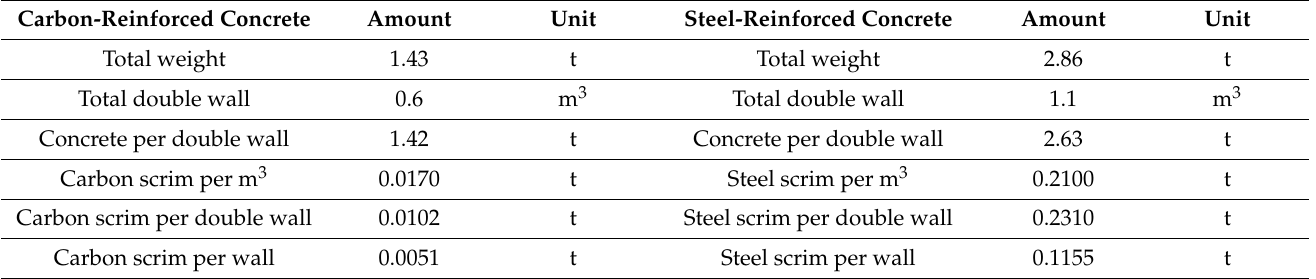
Figure 2. FU: re-usable material out of carbon fiber vs. steel-reinforced double wall analyzed in the study.